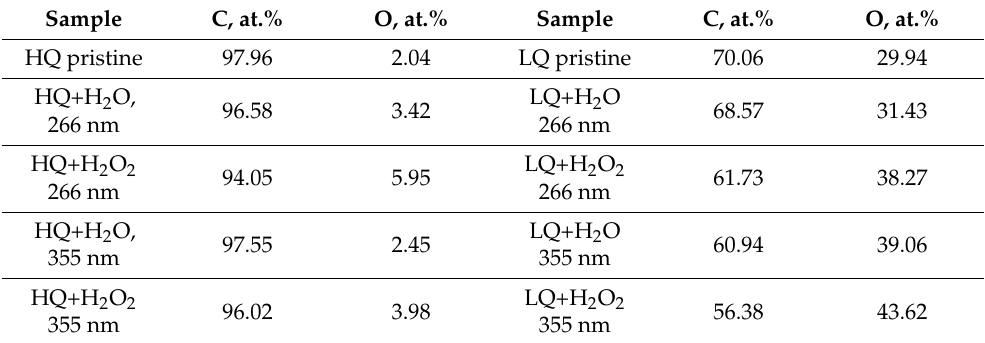
Table 1. Chemical composition of studied pristine and treated HQ and LQ graphite. Sample C,